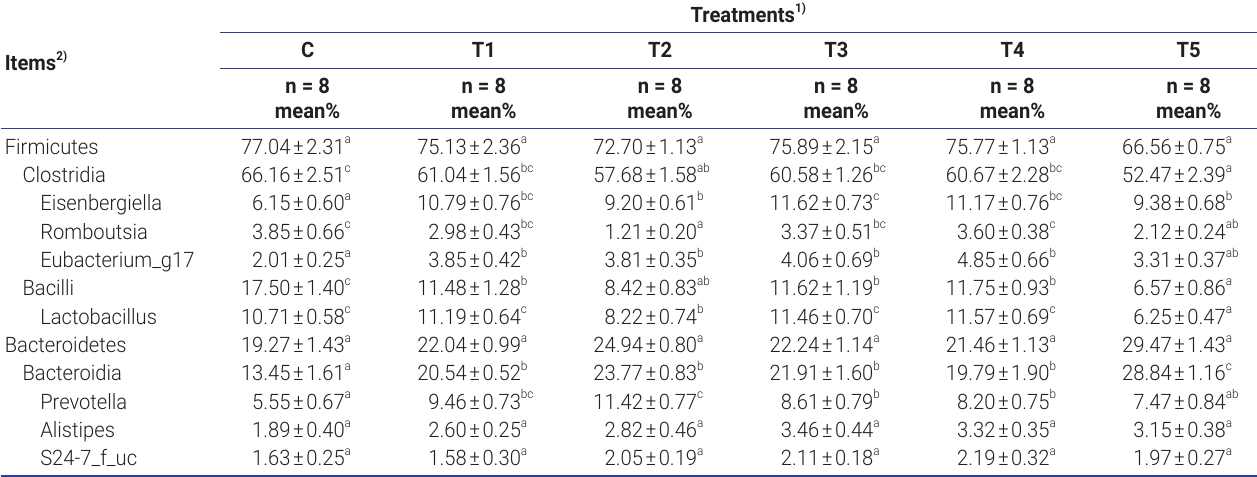
Table 2. Influence of RC -LAB fermented feed and 3 types of LAB on the relative abundance of dominant of phyla, classes and familia in the diges- tive tract of rats by next-generations